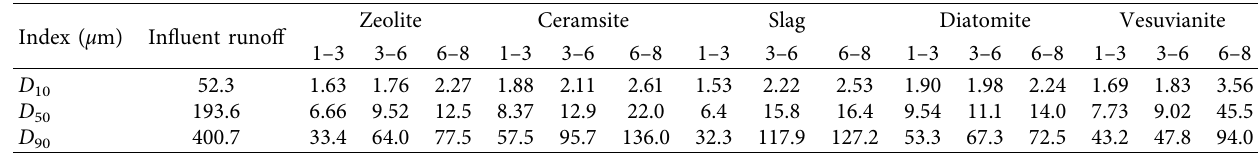
Table 3: Typical diameter indices of runoff through filter media with different layer thickness.